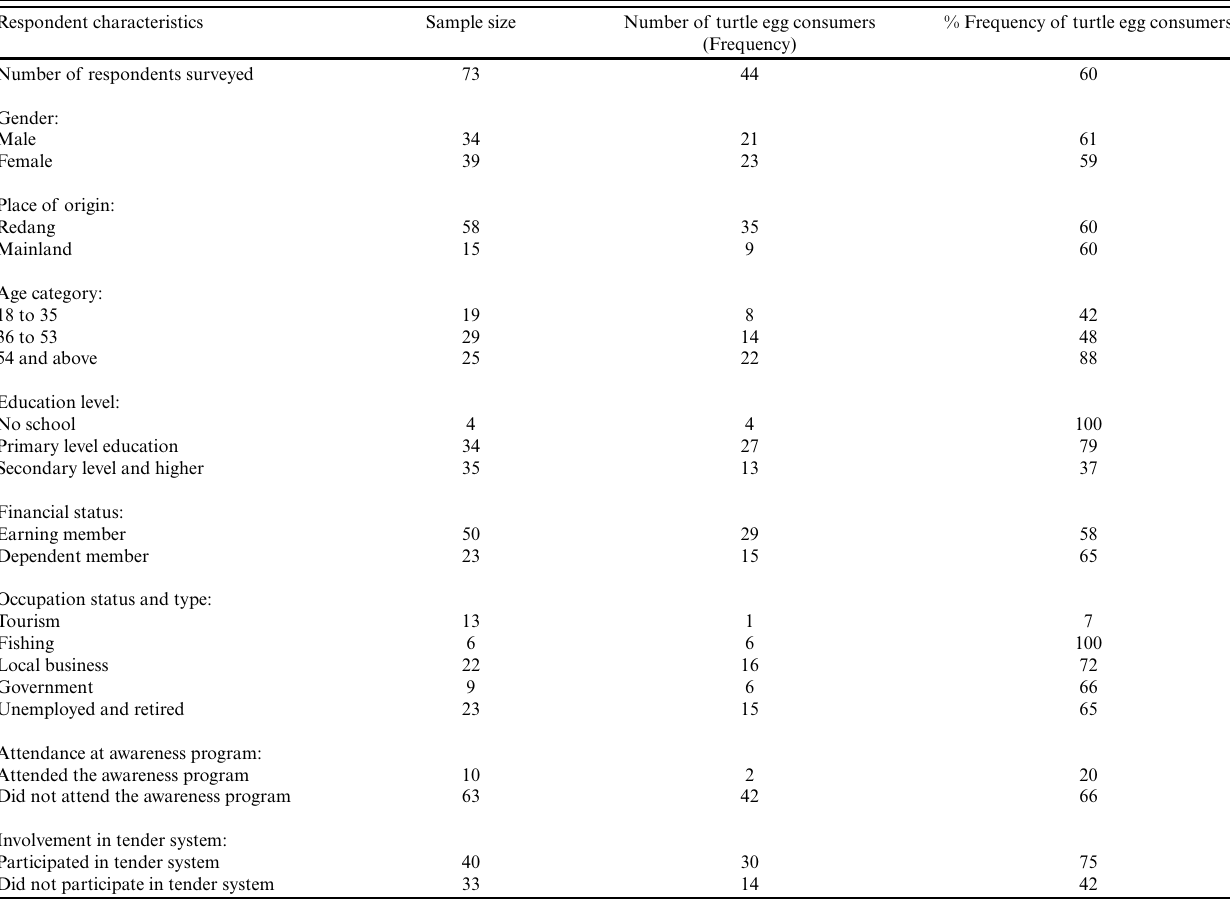
Table 2 . Demographic characteristics of the surveyed respondents (n = 73) in Kampung Baru (Redang Village). The values relate to the number of observations and egg consumer profiles (represented as % frequency).